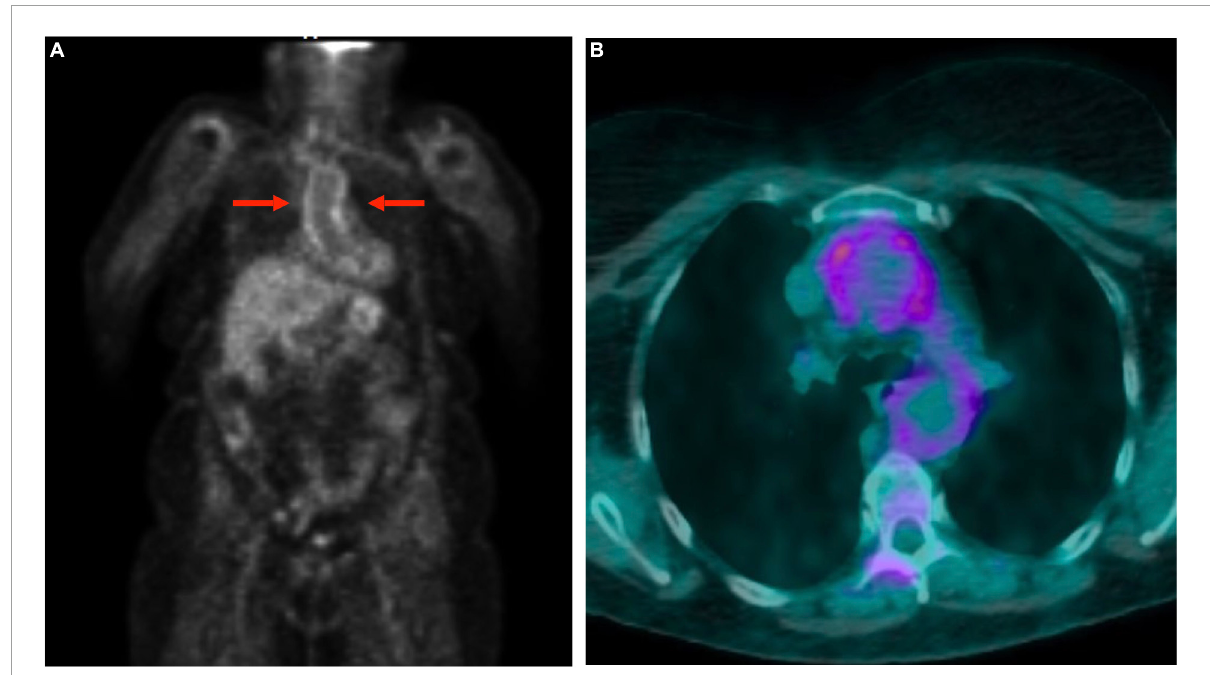
FIGURE1 Total body 18F-fluorodeoxyglucose positron emission tomography-computed tomography ( 18 F-FDG-PET/CT) in a polymyalgia rheumatica (PMR) patient with giant cell arteritis. The images show the involvement of the aorta: uptake of the thoracic aortic wall in maximum intensity projection image (A) and transverse fused (PET and CT) slice (B)